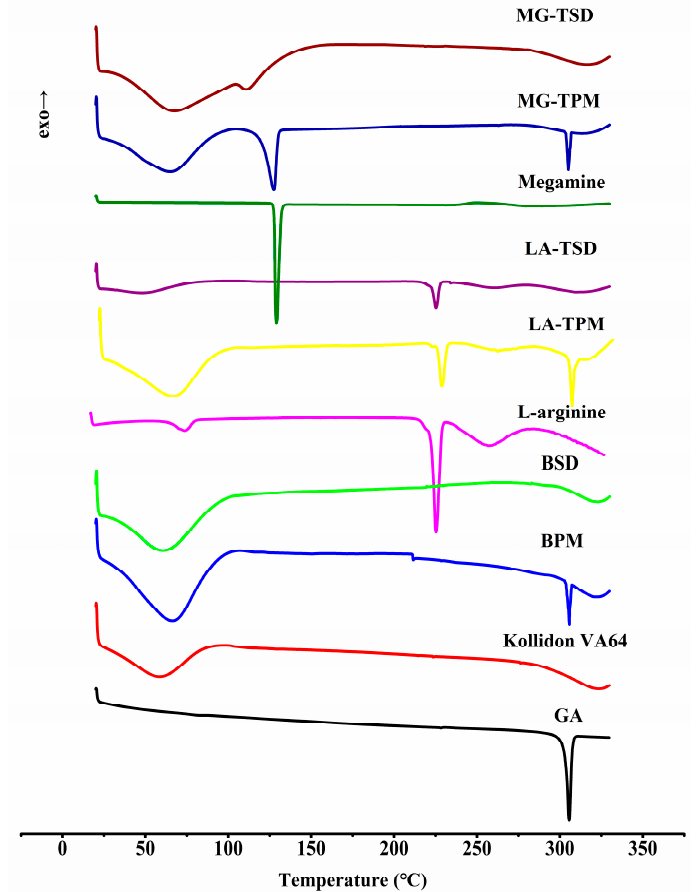
Figure 5. DSC thermograms of GA, Kollidon ® VA64, and their PMs / SDs with and without alkalizers.